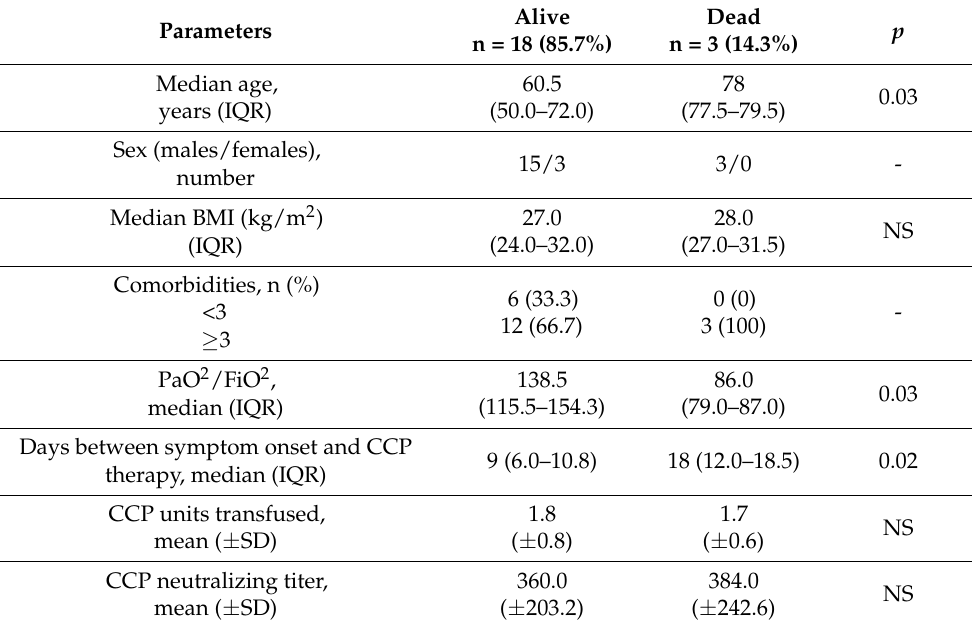
Table 3. Characteristics of CCP-treated COVID-19 patients, dead and